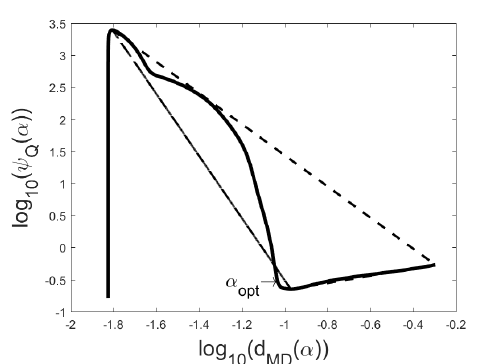
Figure 5. Q-curve in